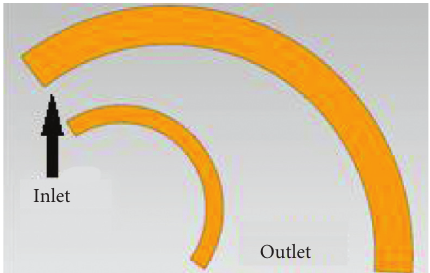
Figure 6: Flow field model of end clearance of internal gear pump.